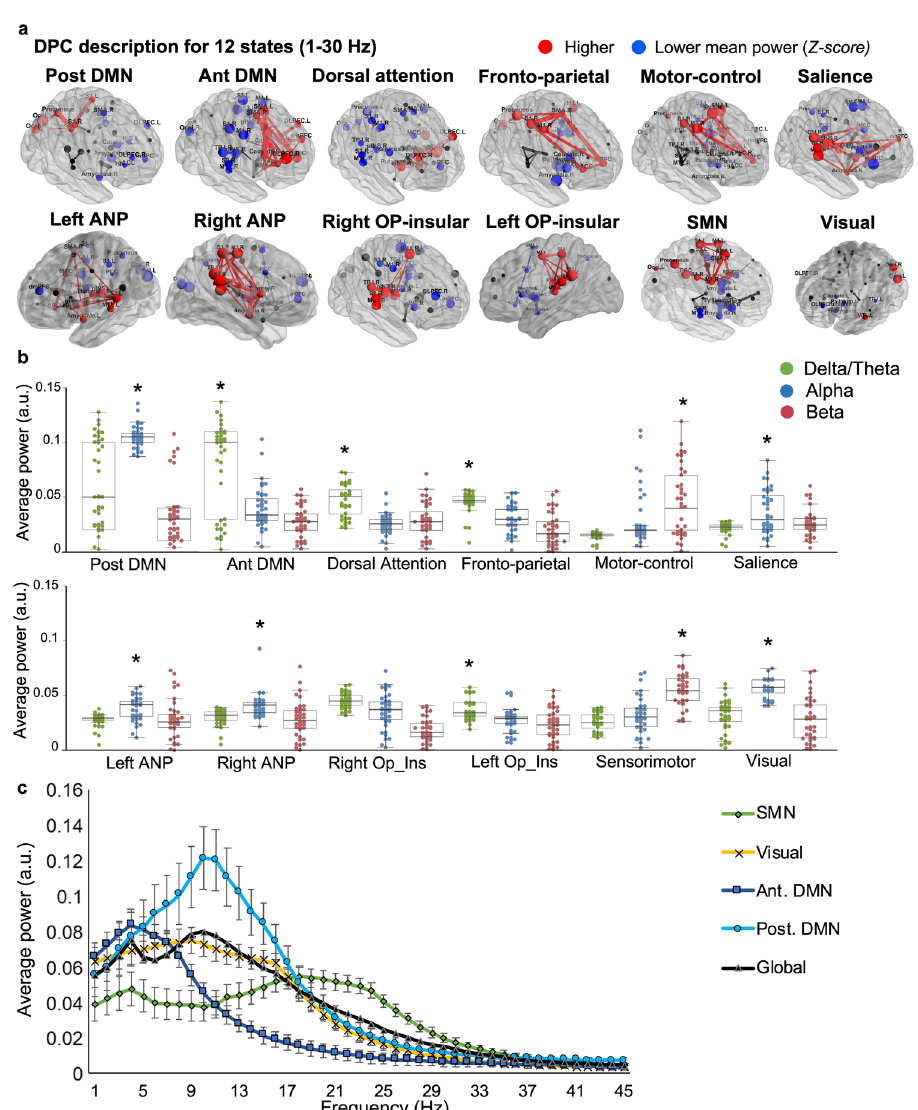
Fig. 2 Brain states identi fi ed using an HMM show functional networks of spectral power and coherence in the DPC. a Brain regions with signi fi cant power and phase-coupling are represented across a wideband frequency range (1 – 30 Hz) for the 12 estimated states in n = 40 healthy controls. Node spectral power is relative to the temporal average, and node size is in relation to the mean power ( Z score) across states (blue and red colors re fl ect power that is lower or higher than the average over states, respectively). Edges between nodes show functional connectivity, and only signi fi cant and high-valued connections are shown. Signi fi cant coherences were mainly found between active nodes in each state. The same 12 states were found in the patients cohort, and the nodes ’ repartition was similar across a wideband frequency range. b Spectral power averaged across all brain regions in brain states as a function of frequency (green: delta/theta, blue: alpha, and red: beta). c Spectral pro fi les of the DMN (post. DMN: blue; ant. DMN: purple), SMN (green), and visual (yellow) states, in terms of power averaged across brain regions, in comparison to the grand average (black line); Standard deviations are represented. * P < 0.001; permutation P value, 5000 bootstrap samples. DMN Default mode network, ANP ascending nociceptive pathway, OP-insular (operculo-insular), SMN sensorimotor, DPC dynamic pain spectral power compared to the HC group in two instances: (1) at alpha frequency in the right ANP (Cohen ’ s d = 0.662 [95.0%CI 0.137, 1.15]; p = 0.0044 two-sided permutation t test, 5000